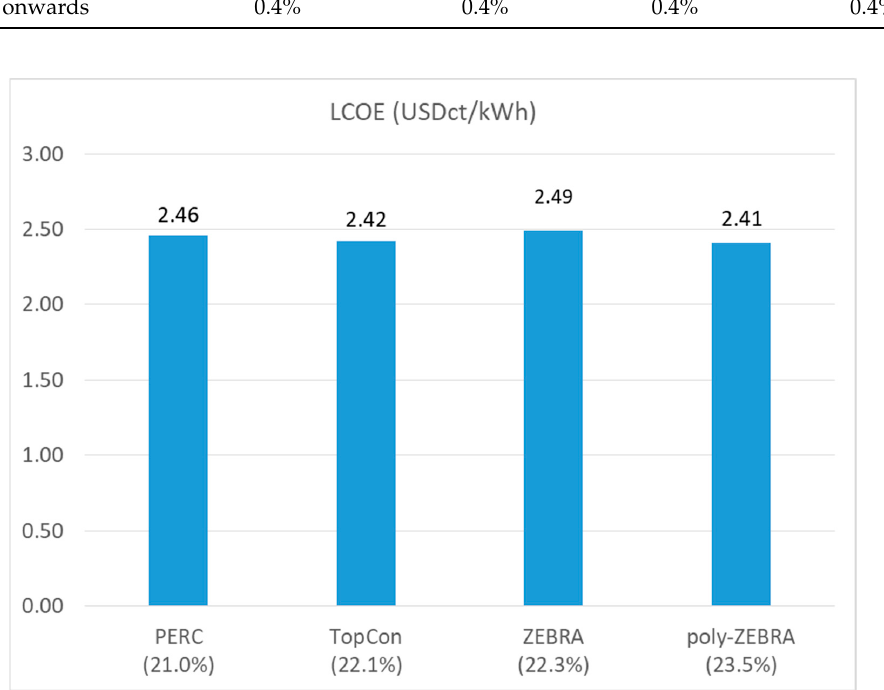
Figure 14. Result of LCOE calculations for different bifacial technologies; the module efficiencies for the respective cell technologies are indicated in brackets. the respective cell technologies are indicated in